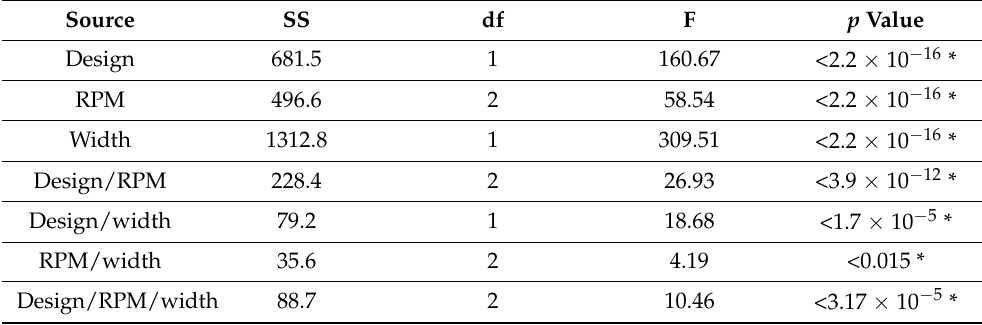
Table 1. Analysis of deviance table; one-, two- and three-way interactions between the